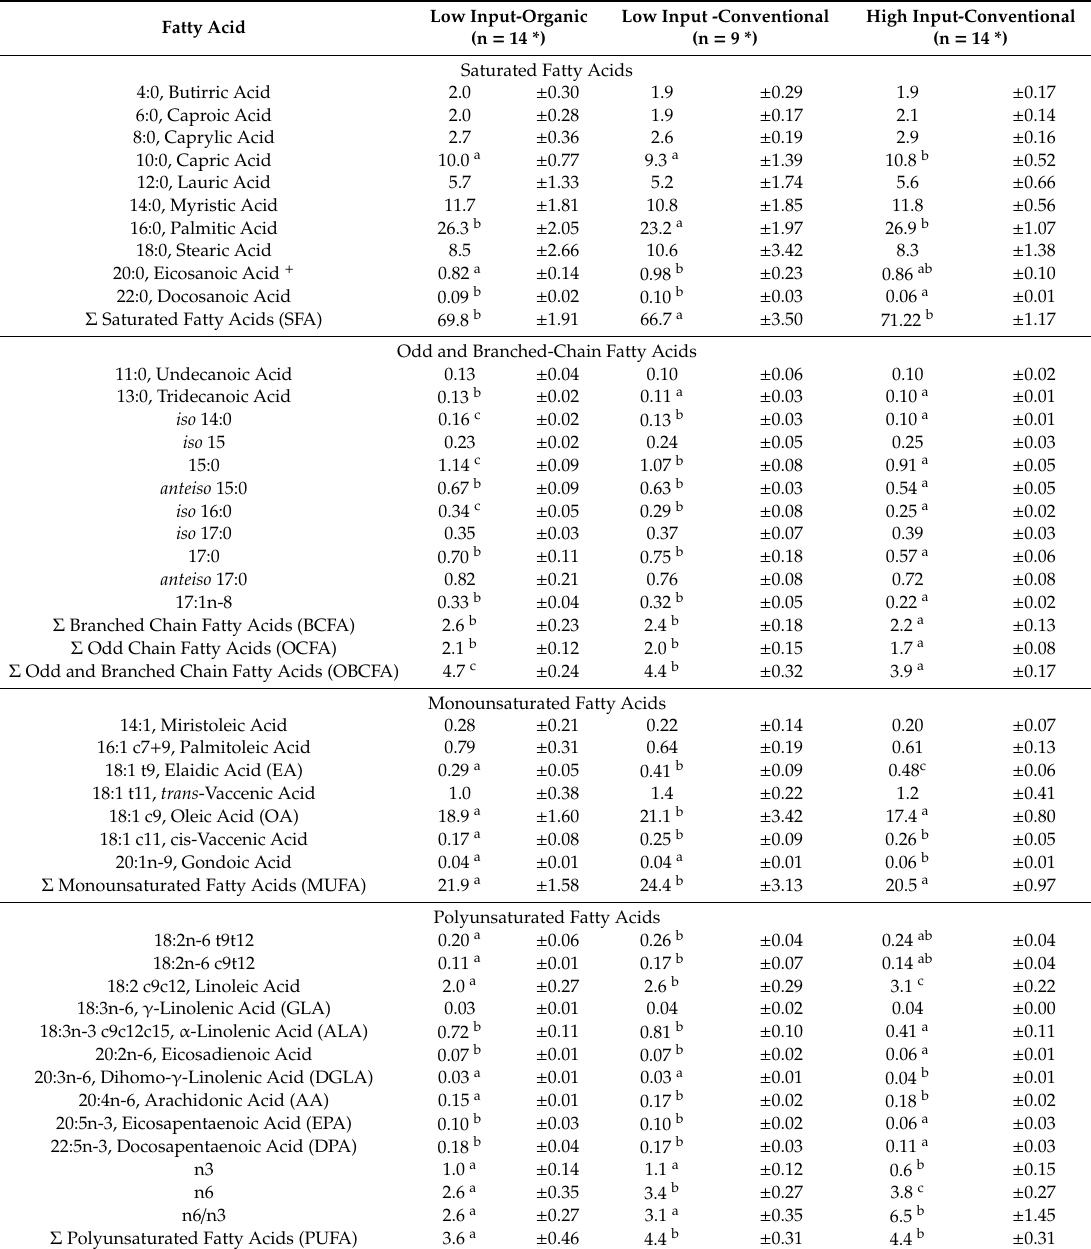
Table 2. Fatty acids (g / 100g of total FA) of bulk goat milk samples. Data are expressed as mean ± standard